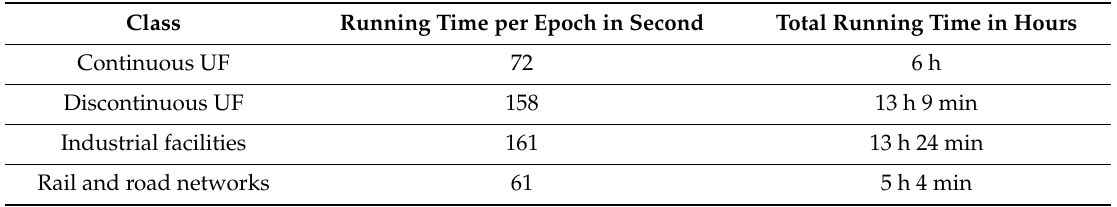
Table 8. The duration of training per